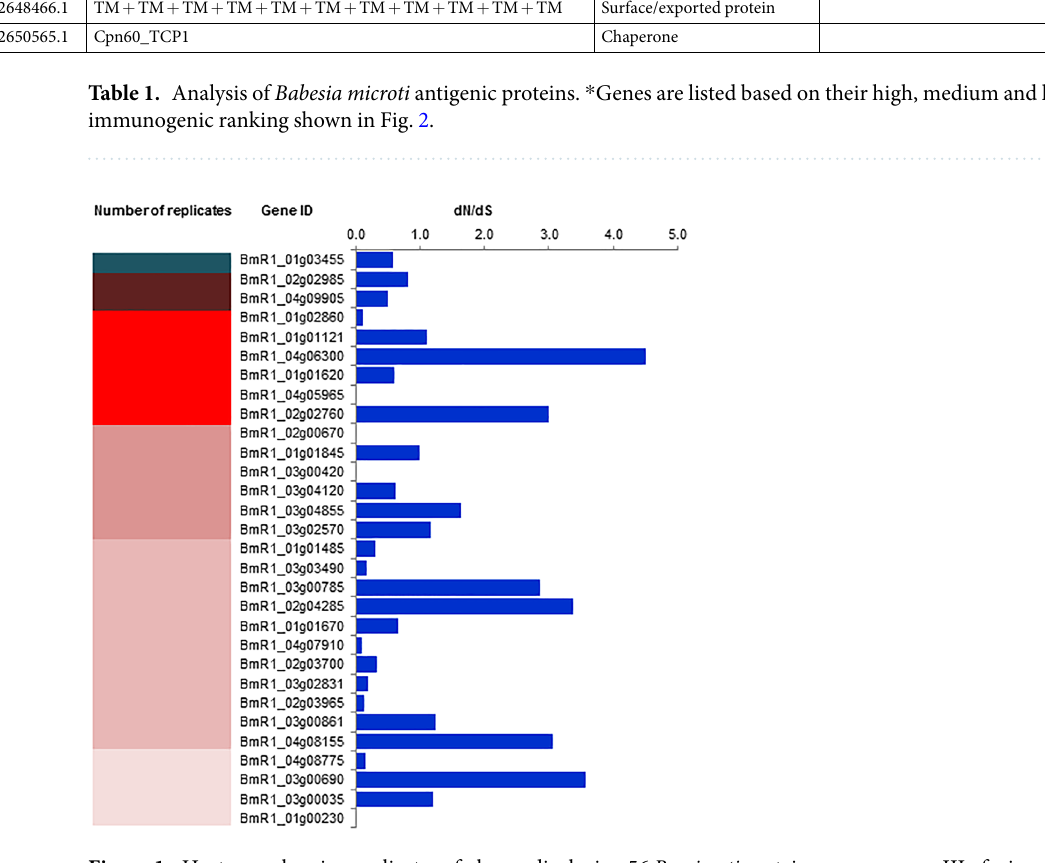
Figure 1. Heat map showing replicates of phages displaying 56 B. microti protein sequences as gIIIp fusion isolated following immunoscreening. The green color indicates the peptide domain isolated with highest frequency while other clones are represented by different intensities of red from highest to lowest frequency. The bar graph on the right shows dN/dS ratio to represent the presence of gene polymorphism as analyzed by aligning the sequences from the 41 B. microti isolates available on